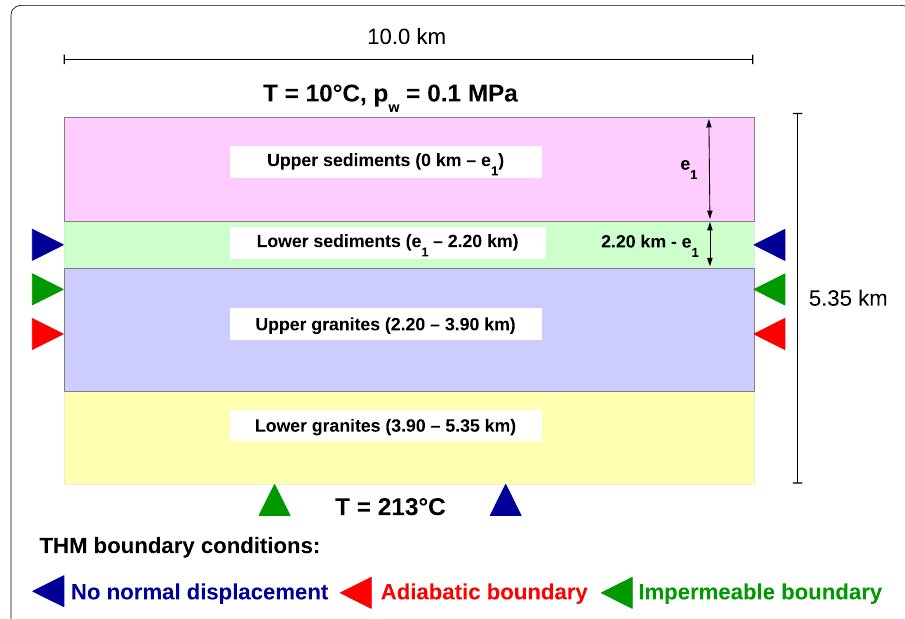
Fig. 2 2D vertical cross section and boundary conditions. The background colors correspond to idealized layers homogenized at the scale of about 100 m. Here, the thickness of the first layer e 1 is evaluated during the back